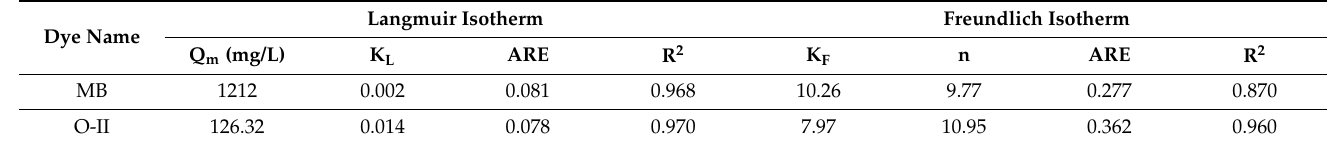
Table 2. Adsorption isotherm parameters for MB and O-II dyes.